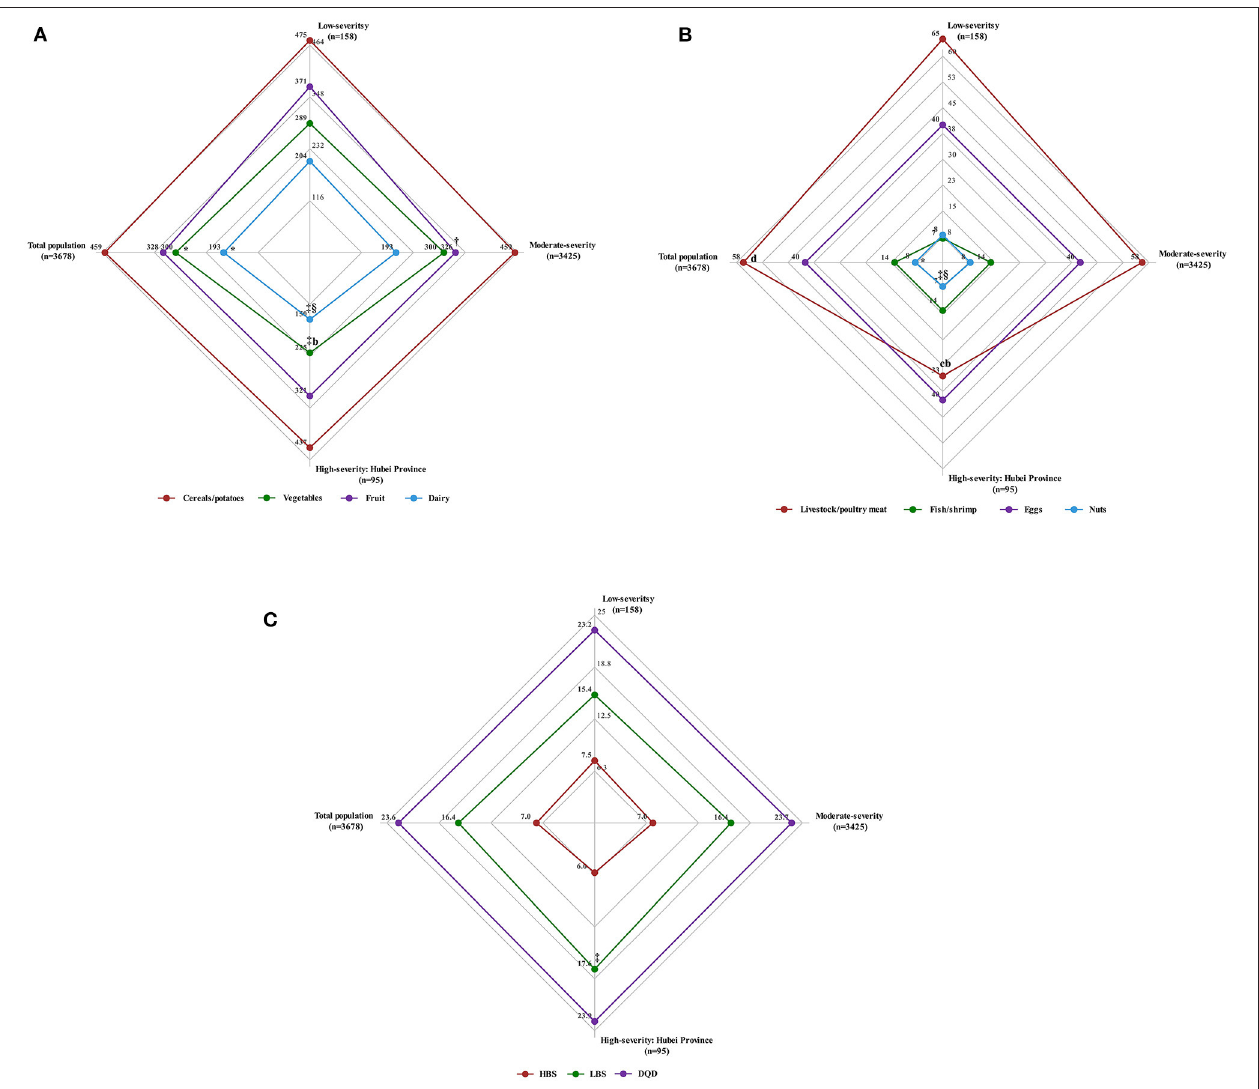
FIGURE 2 | Average daily food intake and diet quality (Diet Balance Index, DBI) for pregnant women according to COVID-19 pandemic severity. (A) The median daily intake of cereals/potatoes, vegetables, fruit and dairy (g/day) for pregnant women according to COVID-19 pandemic severity. (B) The median daily intake of livestock/poultry meat, fish/shrimp, eggs and nuts (g/day) for pregnant women according to COVID-19 pandemic severity. (C) The median of high bound score (HBS), the mean of low bound score (LBS) and diet quality distances (DQD) for pregnant women according to COVID-19 pandemic severity. † p < 0.05 (low vs. moderate severity). § p < 0.05, b p < 0.001 (moderate vs. high severity). ‡ p < 0.05, c p < 0.001 (low vs. high severity). * p < 0.05, d p < 0.001 (low vs. moderate vs. high